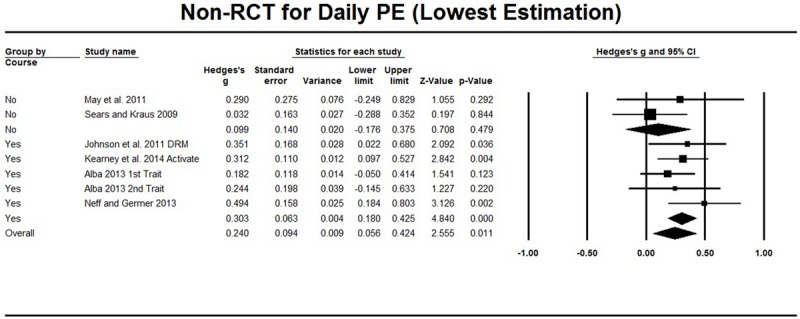
Non-RCT studies on daily PE. The lowest estimation was based on long-term happiness (Trait) in Alba (2013), activated positive emotion (Activate) in Kearney et al. (2014), day reconstruction method (DRM) in Johnson et al. (2011). Subgroup analysis compared LKM with course and without course.